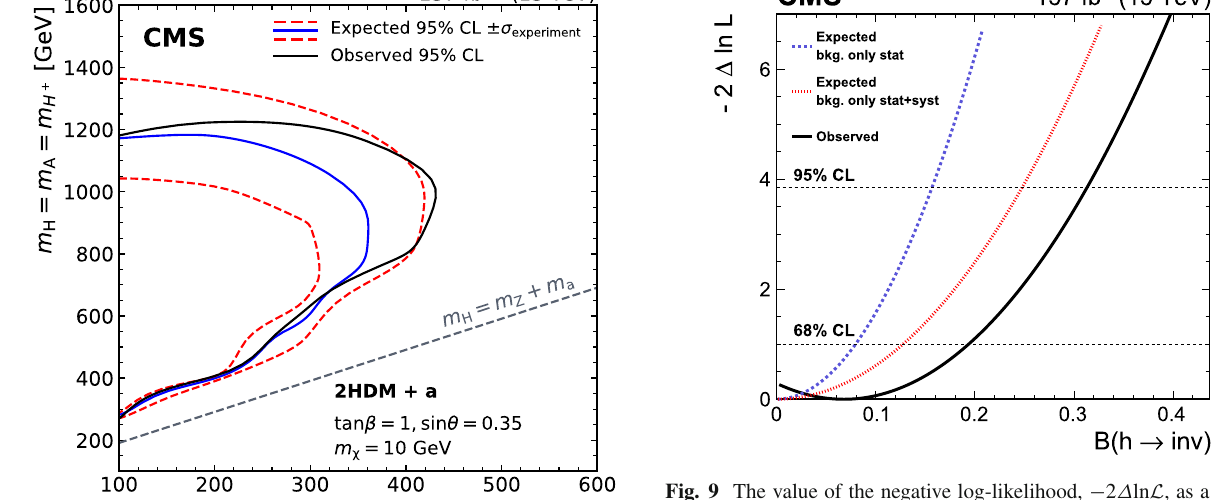
and 0.09 (0.07) pb for d U = 1, d U = 1 . 5, and d U =